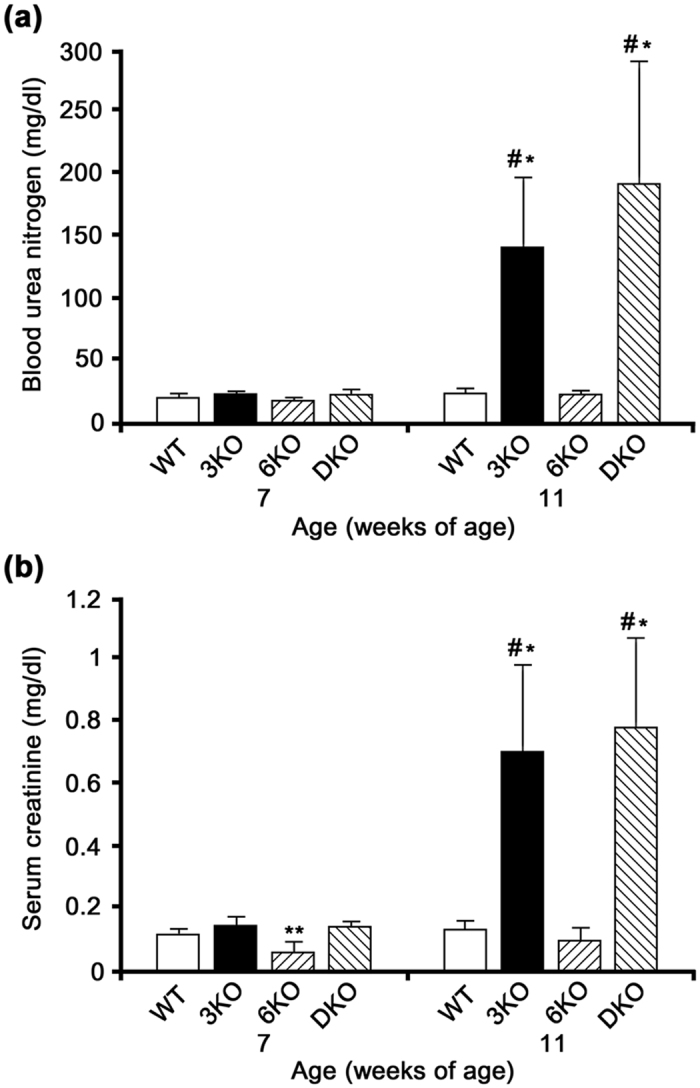
The blood test results were comparable between Col4a3 −/− (3KO) and Col4a3 & 6 −/− (DKO) mice.(a) No significant differences were noted in the blood urea nitrogen (BUN) levels of the 3KO, 6KO, and DKO mice from those of the WT mice at 7 weeks of age. The BUN levels of 3KO and DKO mice were significantly elevated in comparison to those of wild mice (WT) and Col4a6 −/− mice (6KO) at 11 weeks of age (#P < 0.05 versus WT, *P < 0.05 versus 6KO). (b) Although no significant differences were noted in the serum creatinine (Cr) levels of the 3KO and DKO mice from that of the WT mice, the Cr level of the 6KO mice was significantly lower than that of the WT mice at 7 weeks of age (**P < 0.05). At 11 weeks of age, the Cr levels of 3KO and DKO mice were significantly elevated in comparison to those of WT and 6KO mice (#P < 0.05 versus WT, *P < 0.05 versus 6KO). There was no significant difference in the BUN and Cr levels of 3KO and DKO mice at 7 and 11 weeks of age.